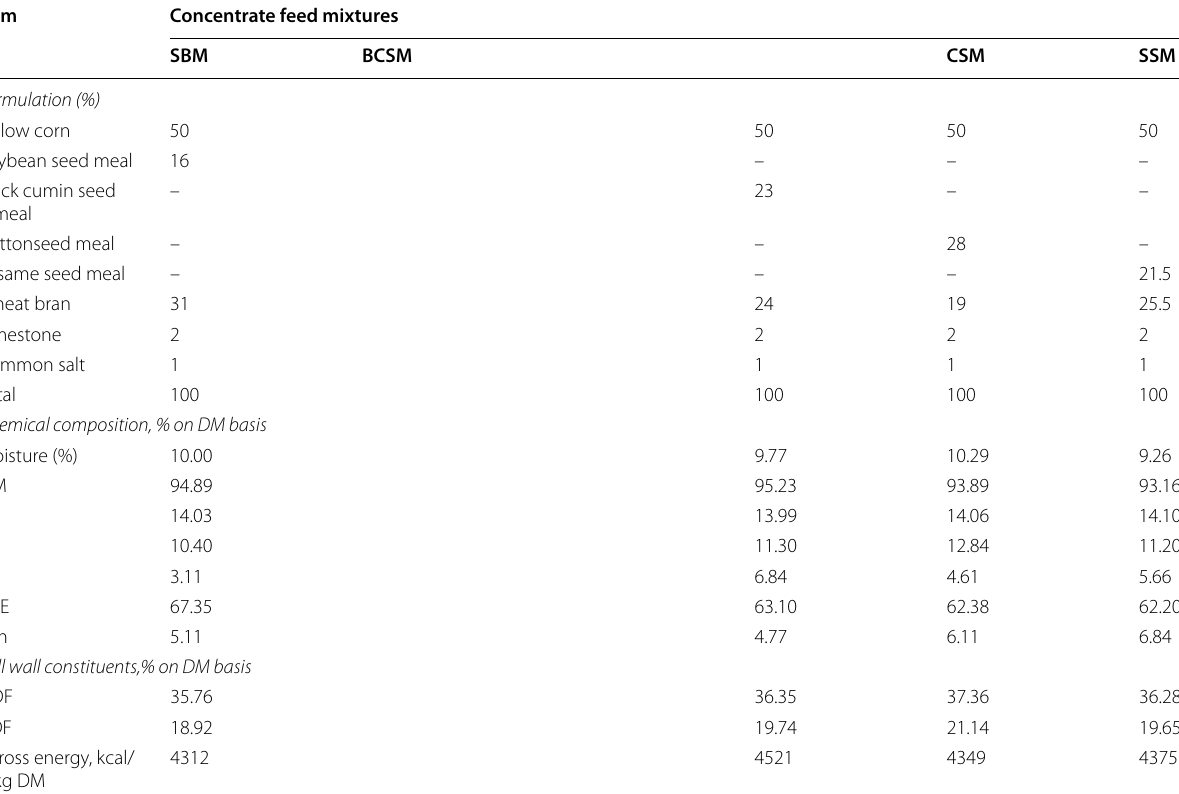
Table 4 Formulation, chemical composition, cell wall constituents and gross energy of the experimental concentrate feed